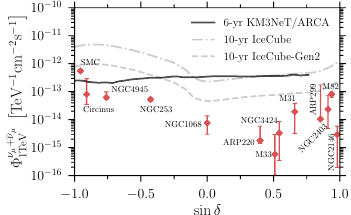
Figure 2. Comparison between the 1 TeV neutrino normaliza- tions according to model A (see [4] for more details) and the Ice- Cube, KM3NeT and IceCube Gen 2 sensititivies for E − 2 point- like sources. Figure taken from Ref.